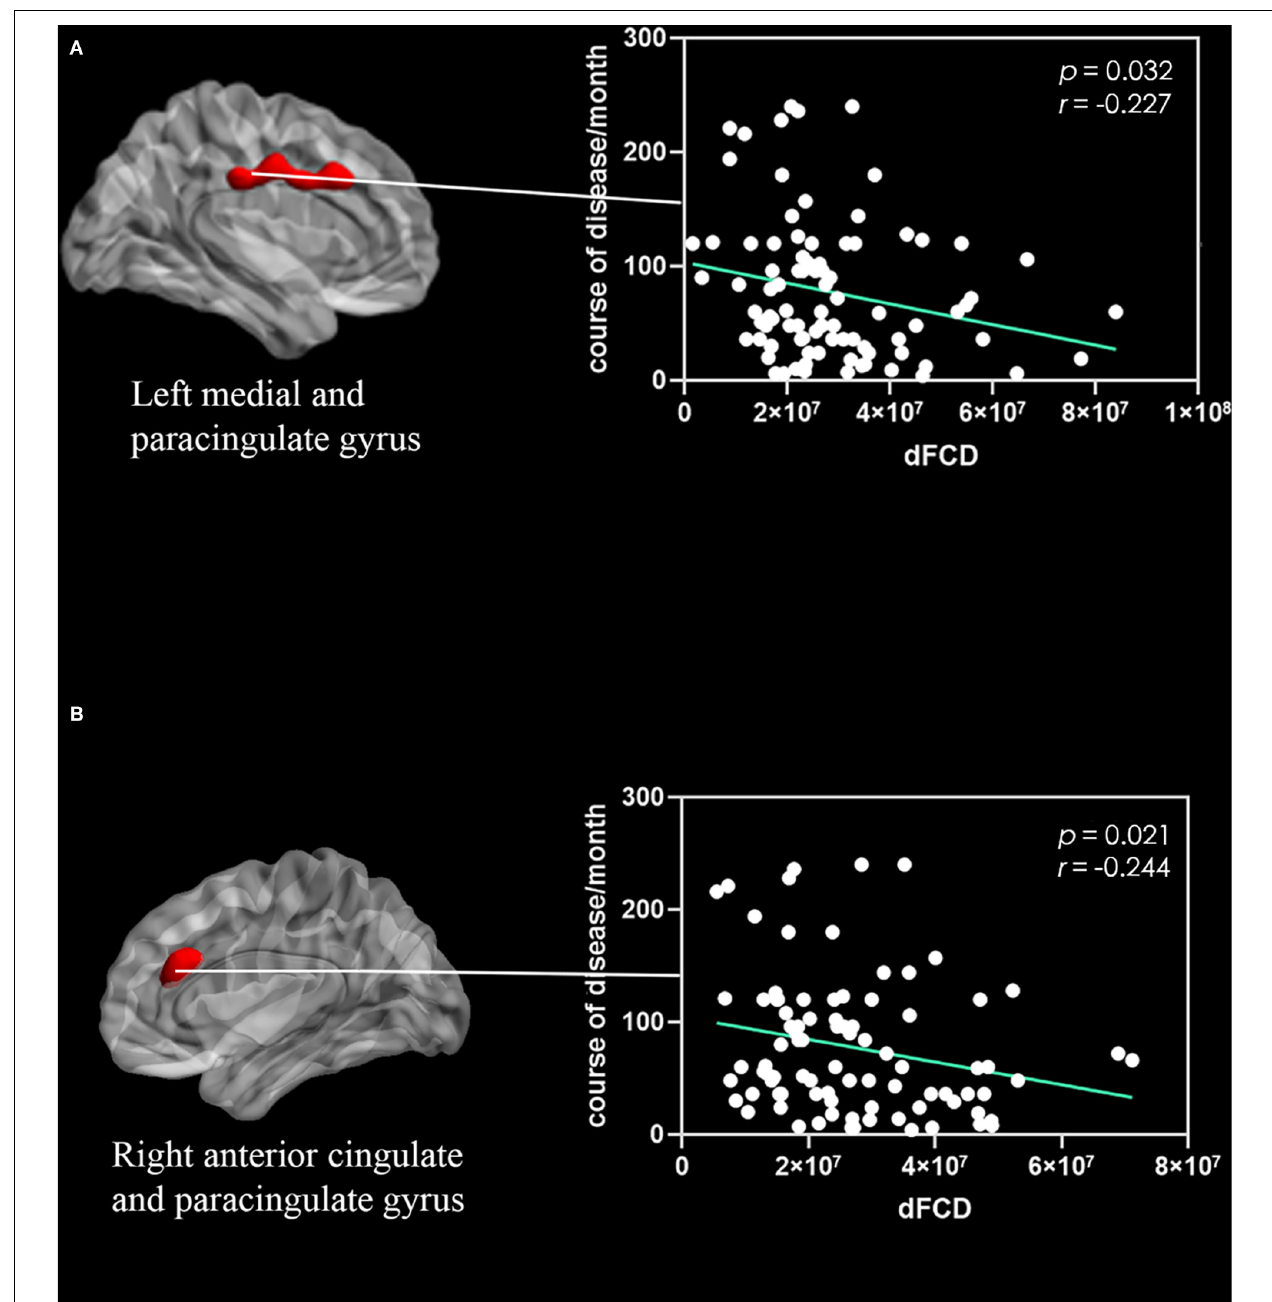
FIGURE 2 | Correlation between dynamic functional connectivity density (dFCD) variability in the left medial and paracingulate gyrus (A) and right anterior cingulate and paracingulate gyrus (B) with the course of disease in CNP group.